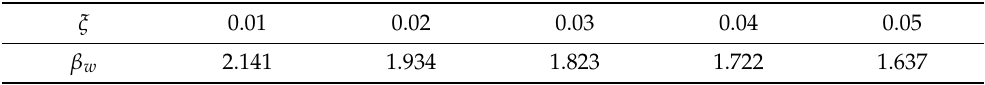
Table 3. Comparison among different ξ value of weighted wind-induced vibration coefficients.